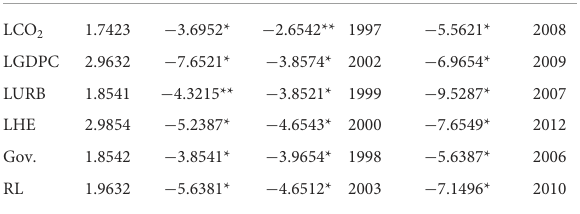
TABLE 3 Pairwise correlation test.